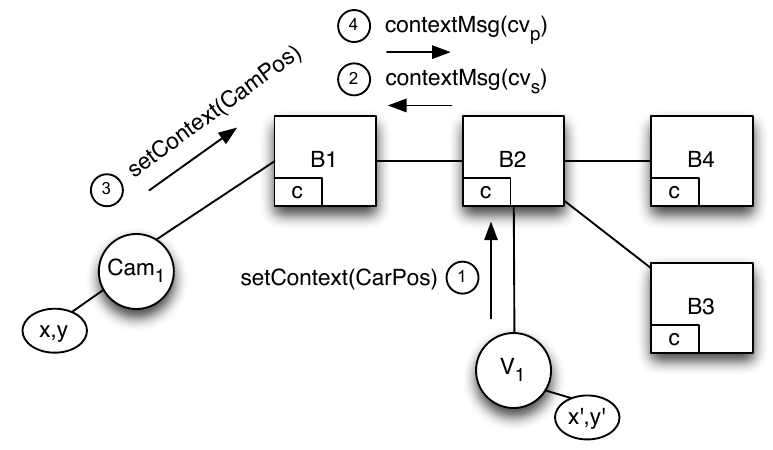
Figure 13. Clients change their